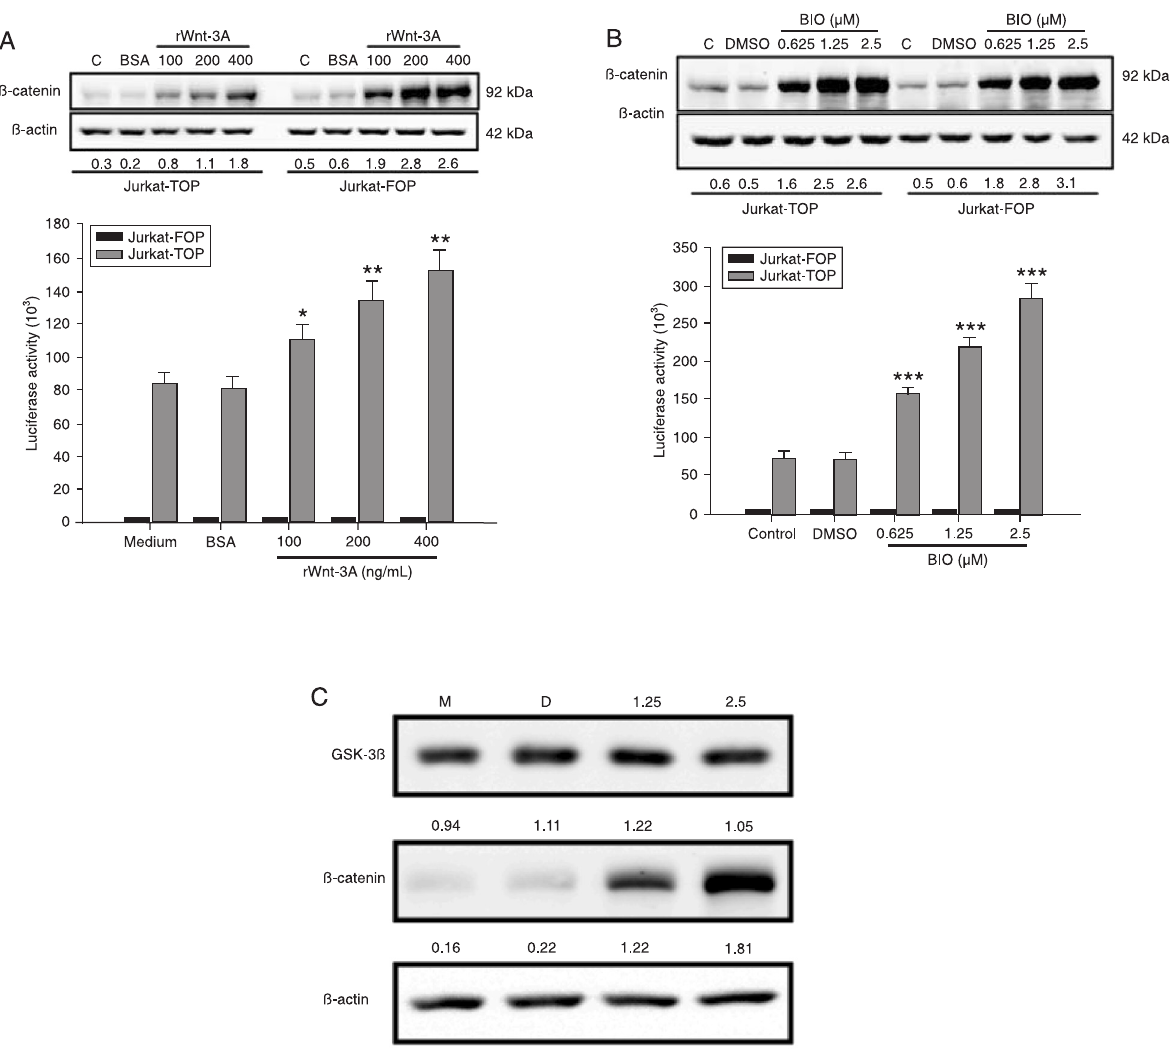
Figure 4. Induction of β-catenin protein and luciferase activity in Jurkat-TOP stable cells by rWnt-3A and BIO. Jurkat-TOP/FOP cells (2 x 10 4 ) were seeded into a 96-well plate for 24 h and then treated with (A) 100, 200, and 400 ng/mL rWnt-3A or (B and C) 0.625, 1.25, and 2.5 µM BIO for 24 and 12 h, respectively. Total cell proteins were collected and subjected to Western blotting and to the luciferase assay. The ratios of β-catenin or GSK-3β to β-actin proteins are shown in the bottom panel. BIO = (2’ Z ,3’ E )-6-bromoindirubin-3’-oxime. *P < 0.05, **P < 0.01 vs cells treated with BSA. ***P < 0.001 vs cells treated with DMSO (Student t -test). Lane M = medium; lane D =